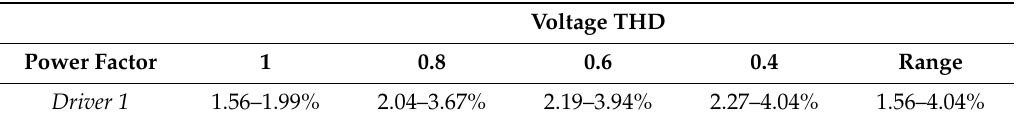
Table 5. THD of the load voltage obtained adopting series gate pulses strategy in Driver 1.